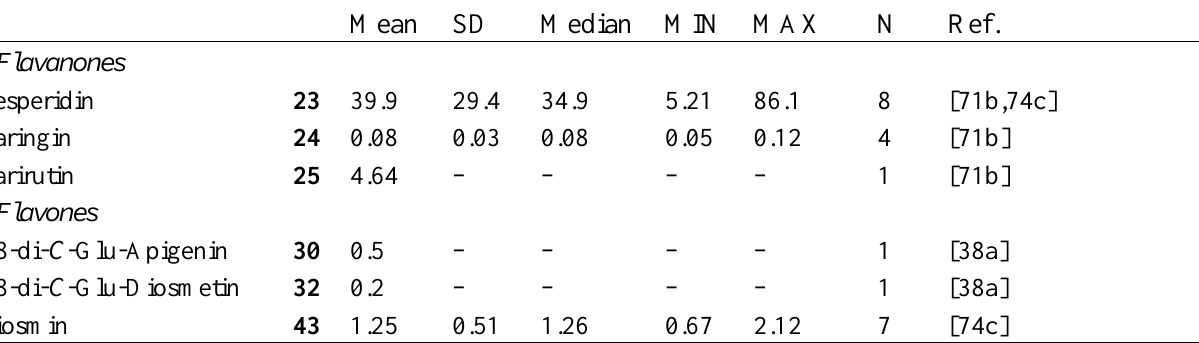
Table 9 . Flavonoid composition of C. clementina juice (mg/100